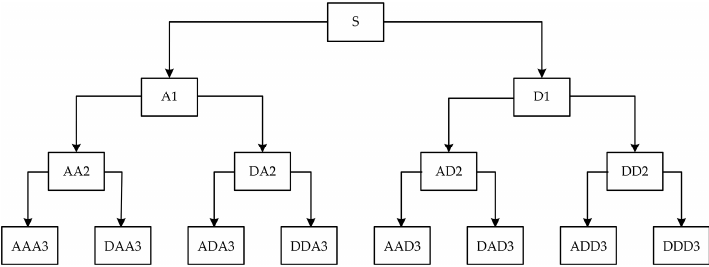
Figure 1. Three-layer wavelet packet decomposition tree.